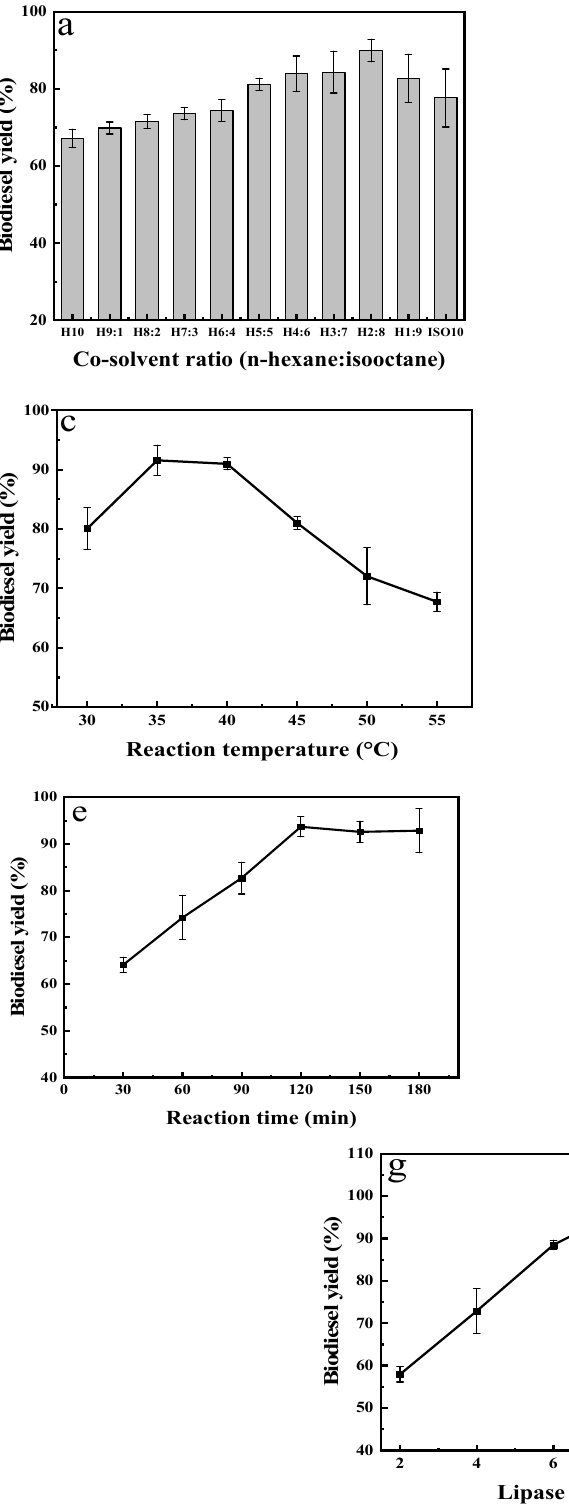
Figure 9. Effect of different transesterification parameters on the yield of biodiesel (%): ( a ) co-solvent ratio; ( b ) molar ratio of methanol to oil; ( c ) reaction temperature; ( d ) amount of co-solvent; ( e ) reaction time; ( f ) water content; ( g ) lipase dosage. The optimal conditions were the following: 1:4 n-hexane to isooctane ratio; 4:1 molar ratio of methanol to oil; 35 ± 1 °C reaction temperature; 20% co-solvent; 120 min reaction time; 8% lipase dosage.